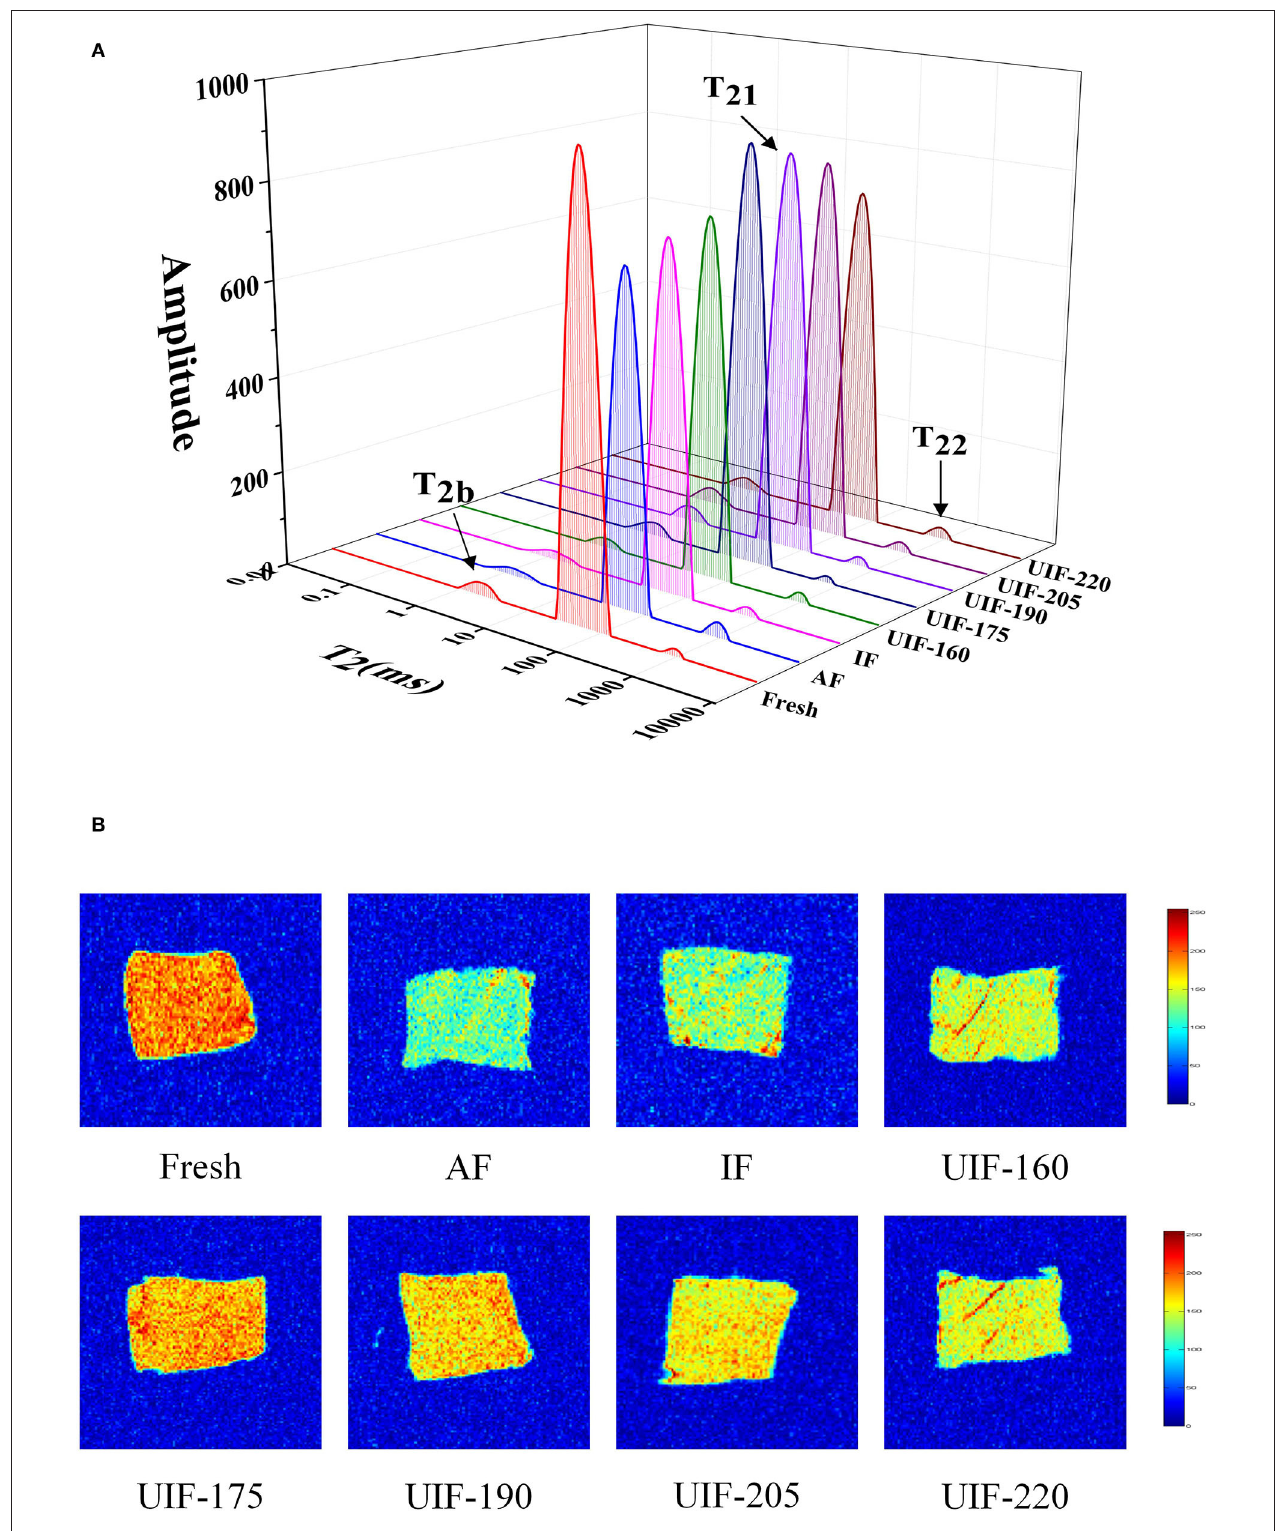
FIGURE 6 | Influence of different freezing treatments on the water distribution (A) and magnetic resonance imaging (B) of the large yellow croaker.